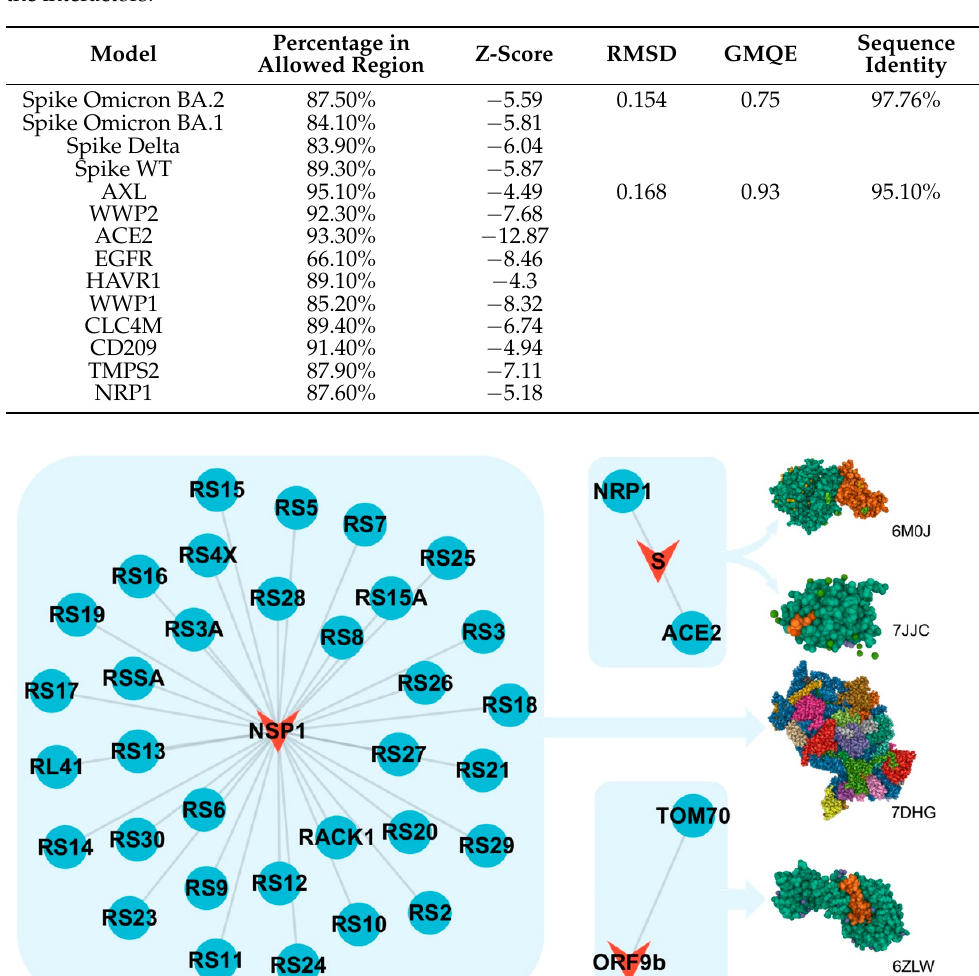
Table 2. Summary of the quality assessment scores for the models of SARS-CoV-2 S proteins and the interactors.